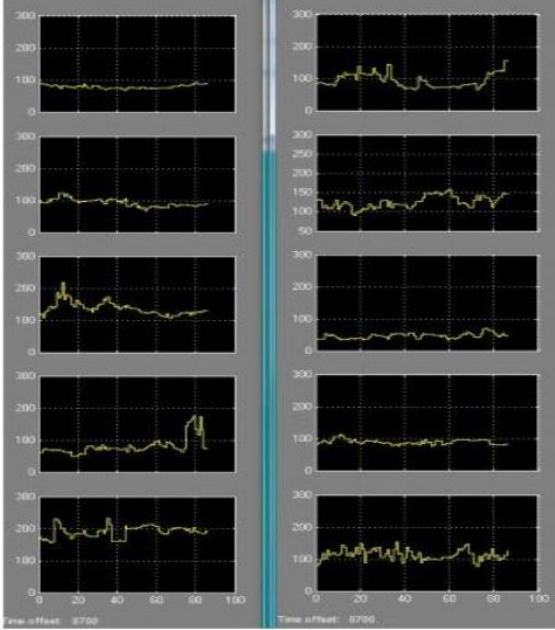
Figure 6: Final Voltage